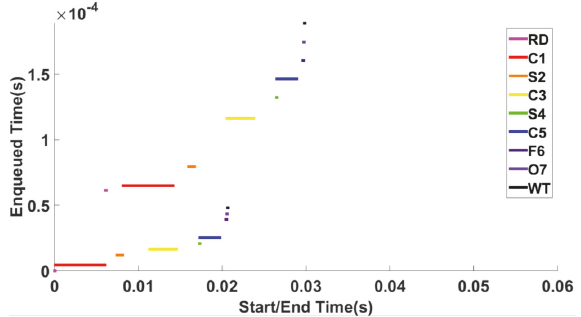
Figure 14: The time distribution with